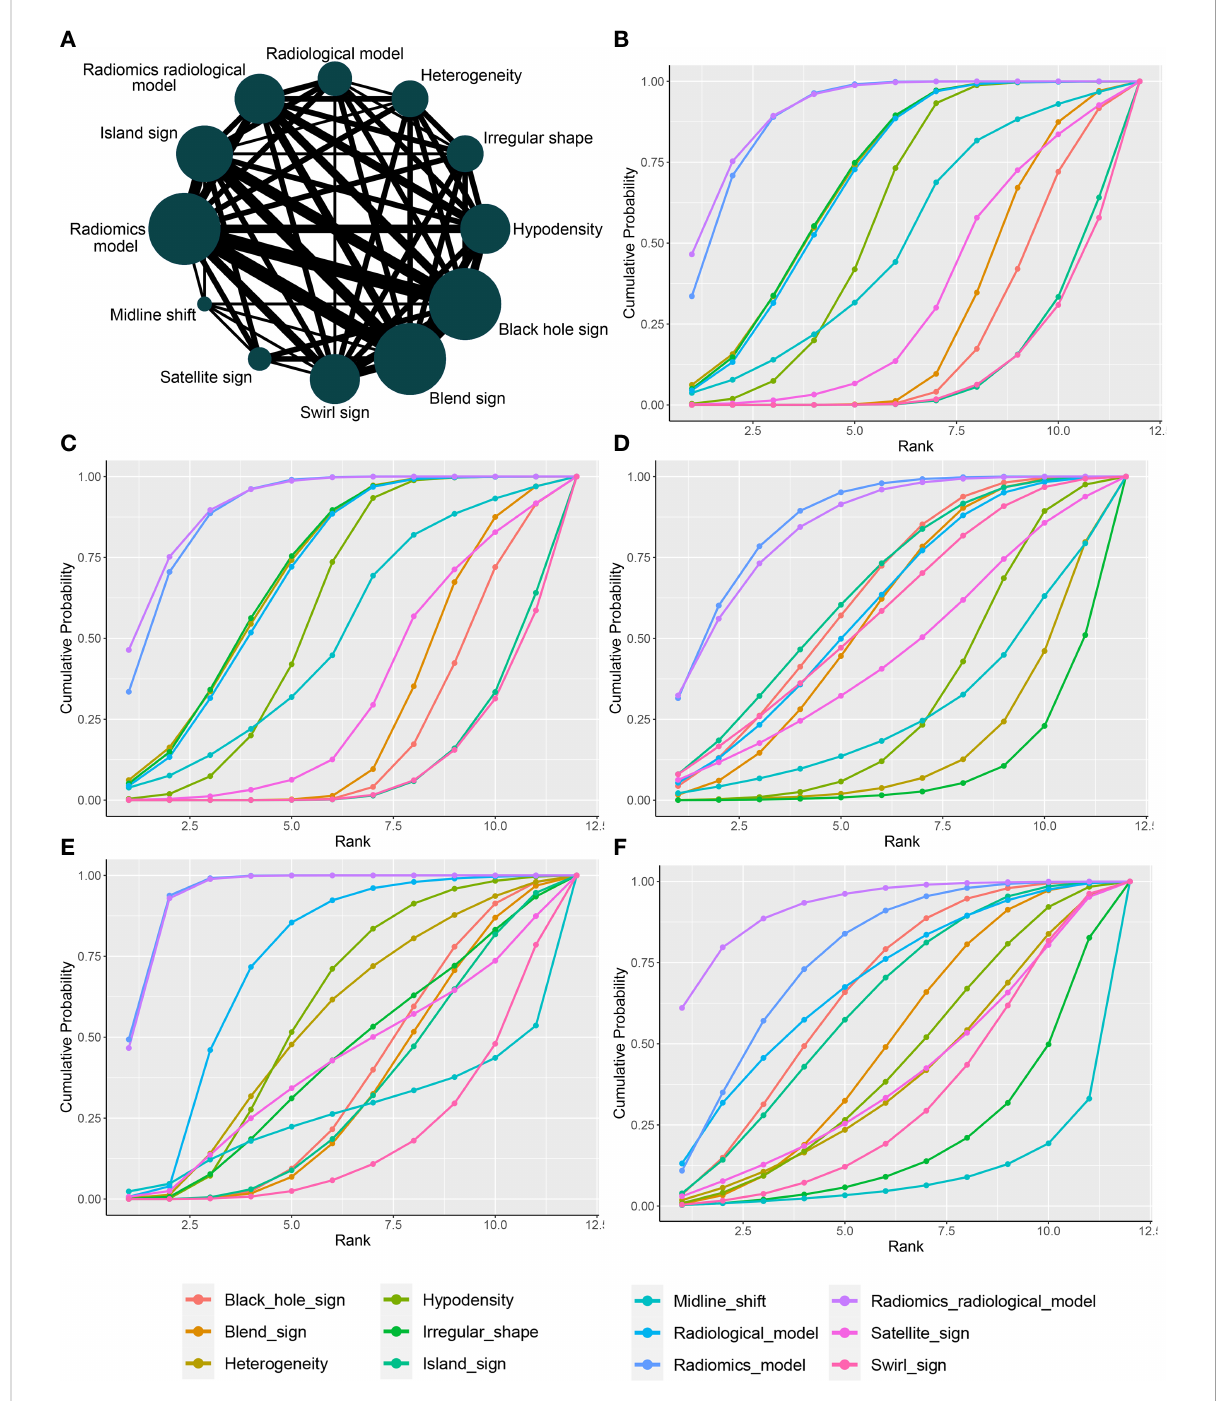
FIGURE 4 Network plot and SUCRA of biomarkers for ranking the accuracy of diagnosis. (A) The network plot of Bayesian network meta-analysis; (B) sensitivity; (C) speci fi city; (D) positive predictive value; (E) negative predictive value; (F) diagnosis accuracy rate. SUCRA: Surface under the cumulative ranking